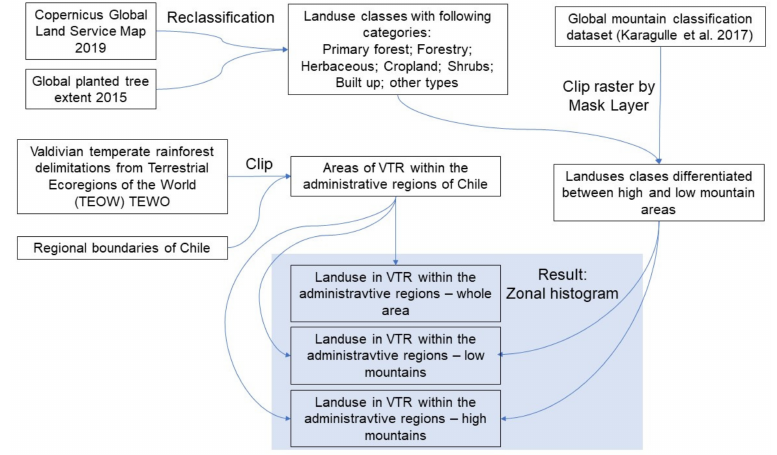
Figure 2. GIS workflow process to calculate the land use classes within area of interest.